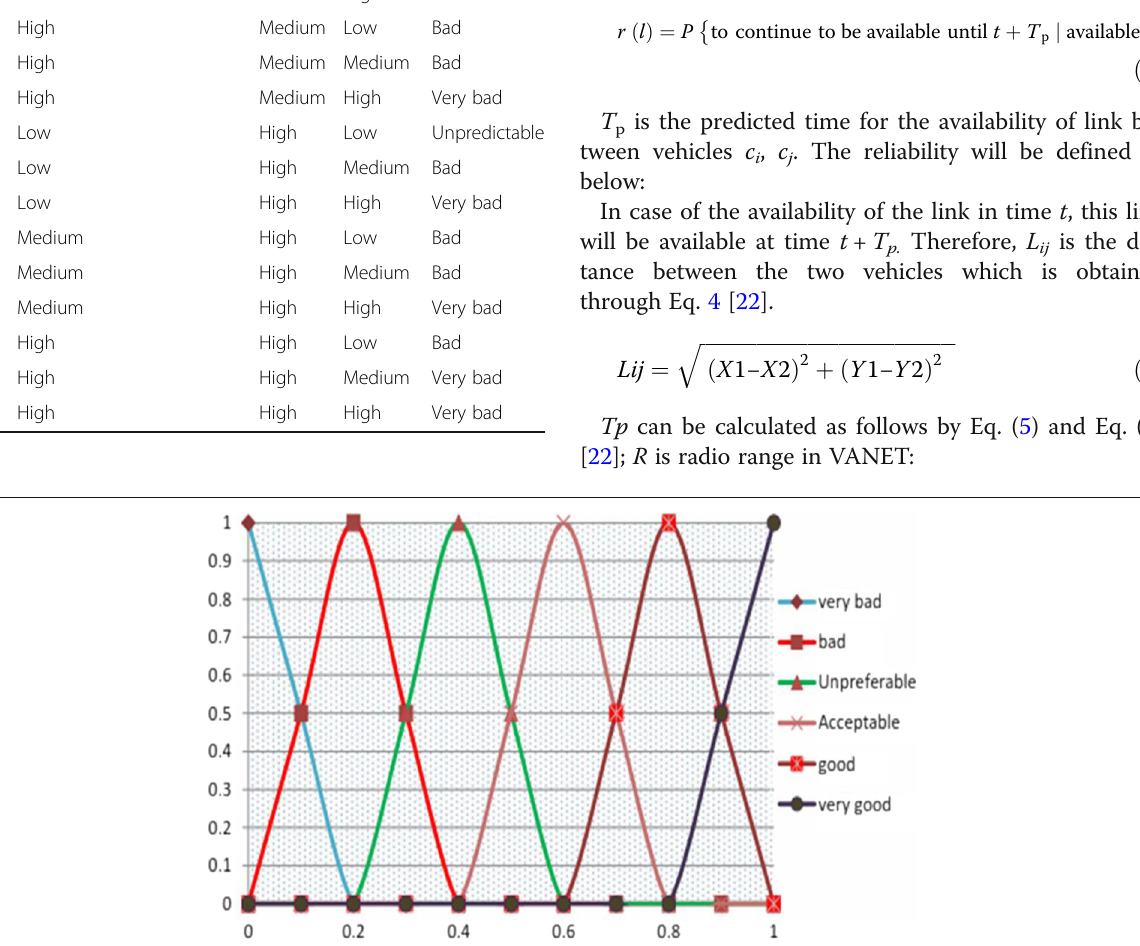
Fig. 5 Fuzzy member function for the fuzzy priority. Defuzzification is the process of generating numerical data based on the output member function. The outputs of this system are shown in this figure. In TIHOO, unlike previous protocols, the fuzzy logic system is not used to determine the optimal path but determines the proper neighboring nodes for reception